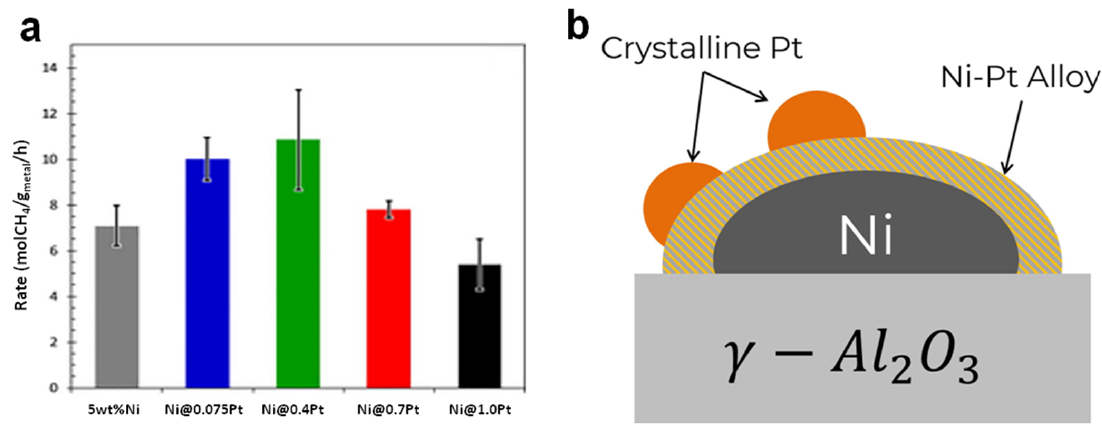
Figure 2. ( a ) Steady state CH 4 conversion rates at 550 ◦ C. ( b ) Proposed structure for electroless deposition-derived Ni–Pt samples. Reproduced with permission from [53]. Copyright 2020, Elsevier.